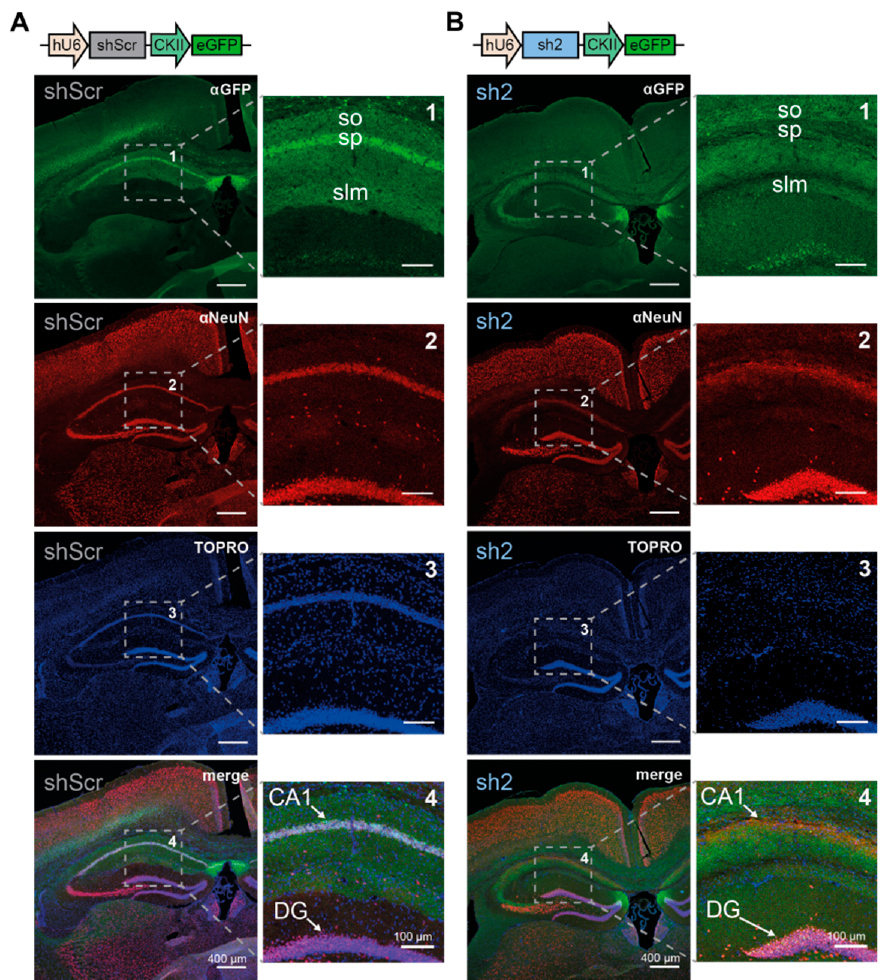
Figure 5. Loss of hippocampal CA1 pyramidal cell layer 5 weeks post-injection of rAAV9-sh2 and control virions. Representative immunofluorescent images showing expression of the eGFP-reporter (green), the neuronal marker protein NeuN (red), and the nuclear marker TOPRO (blue) in ( A ) rAAV9-shScr or ( B ) rAAV9-sh2 bilaterally injected dorsal hippocampi. Animals were sacrificed 5 weeks post-injection. Proteins were stained using specific primary antibodies combined with fluorescently labeled secondary antibodies. Enlargements and arrows show CA1 pyramidal cell layer and the dorsal part of the DG granule cell layer of the hippocampus. Cartoons of the rAAV-delivered constructs are displayed above the immunofluorescent images. so: stratum oriens; sp: stratum pyramidale; slm: stratum